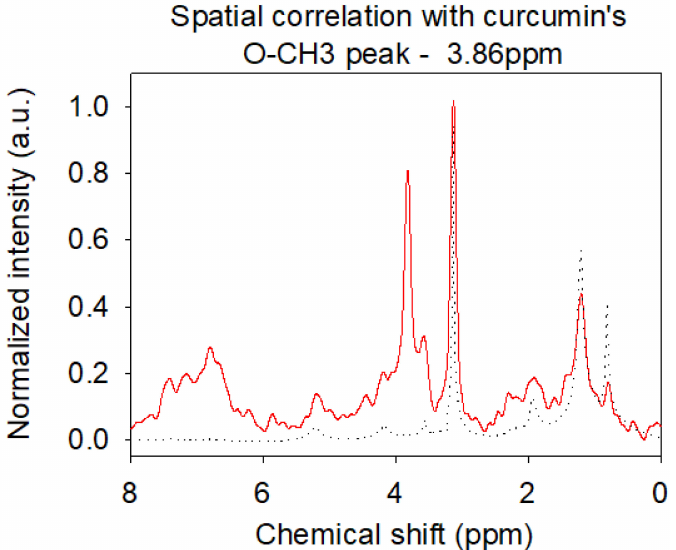
Figure 7. 2D NMR slice of the spatial correlation of curcumin’s O-CH3 groups with other protons. Red line: DOPC bilayer. Black line: curcumin in